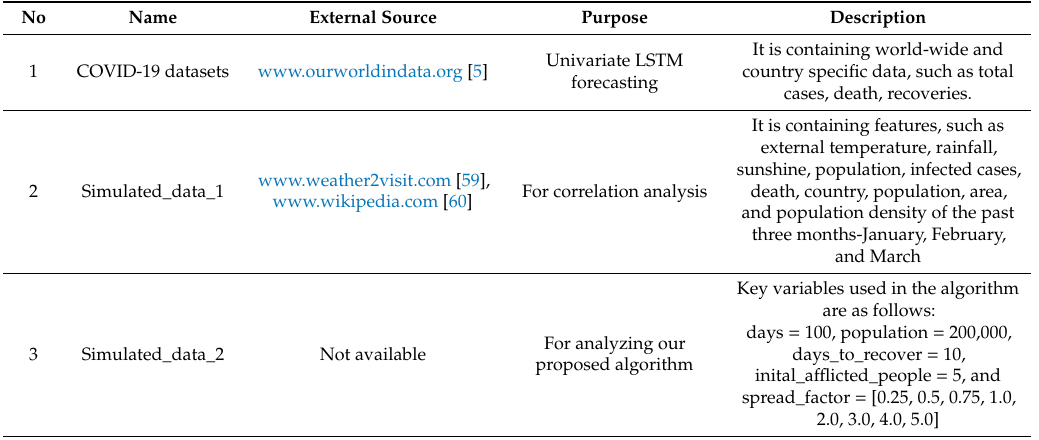
Table 3. Description of selected